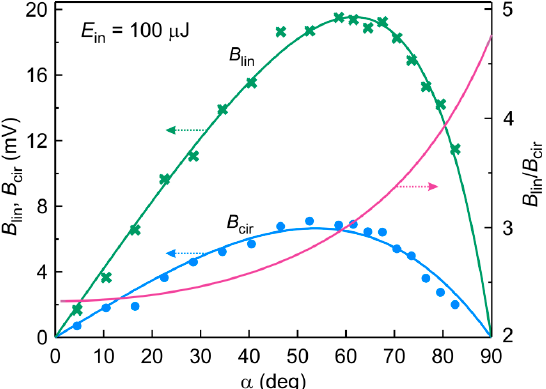
Figure 8. The coefficients B lin (green crosses), B cir (blue dots) as a function of the angle of incidence α , which characterize the linear and circular contributions to the transverse photovoltage pulses, calculated from the experimental data (the green and blue curves represent the corresponding approx- imations by the equations B lin = 55.98sin2 α / ( 1.15cos α + 1 ) 2 , B cir = 11.75sin2 α / ( 0.5cos α + 1 ) 2 , respectively), and calculated dependence of the ratio B lin / B cir on α (pink